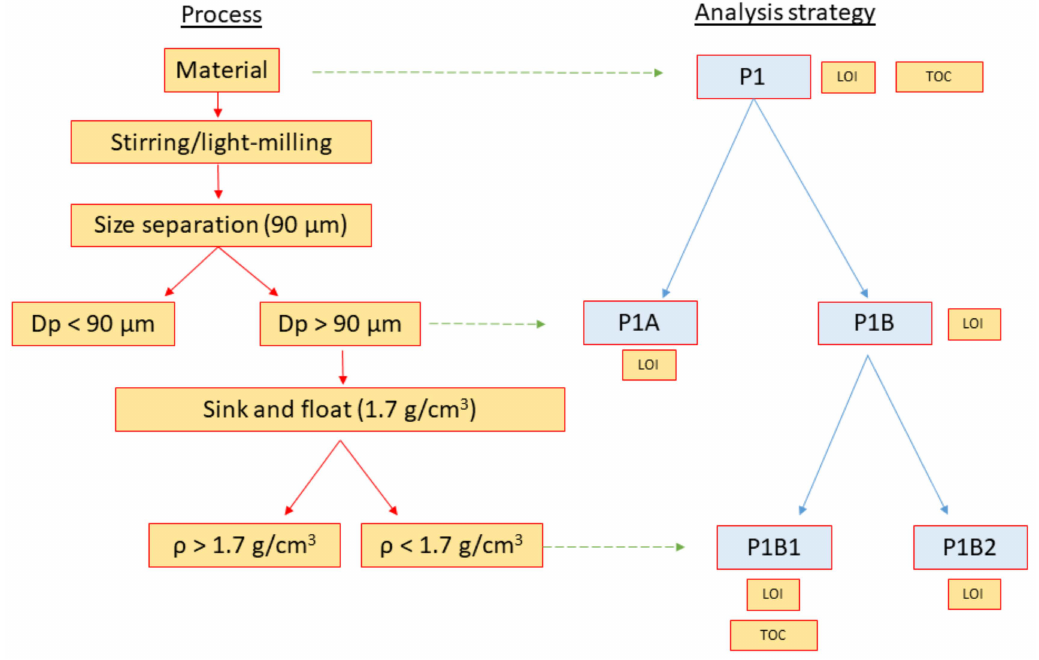
Figure 3. Scheme to obtain liberation of the volatile material contented in the sand, and analysis Scheme.